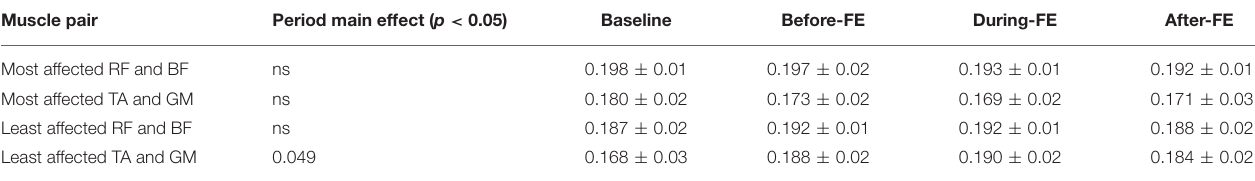
TABLE 3 | Mutual information (Group means ± SD) within lower limb muscle pairs during stepping-in-place task across four periods in individuals with Parkinson’s disease who experienced freezing in the study. Muscle